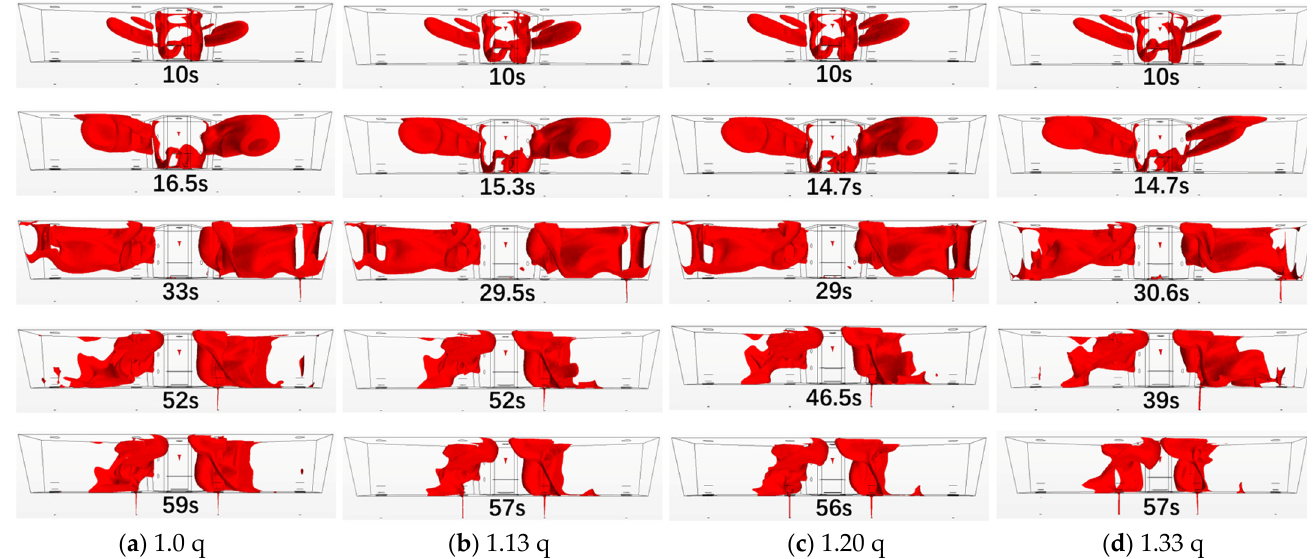
Figure 17. Isosurface evolution results of the u-shaped weir tundish with uniform increasing casting flow rate under strand 1 blockage condition ( ω = 10 − 5 ).